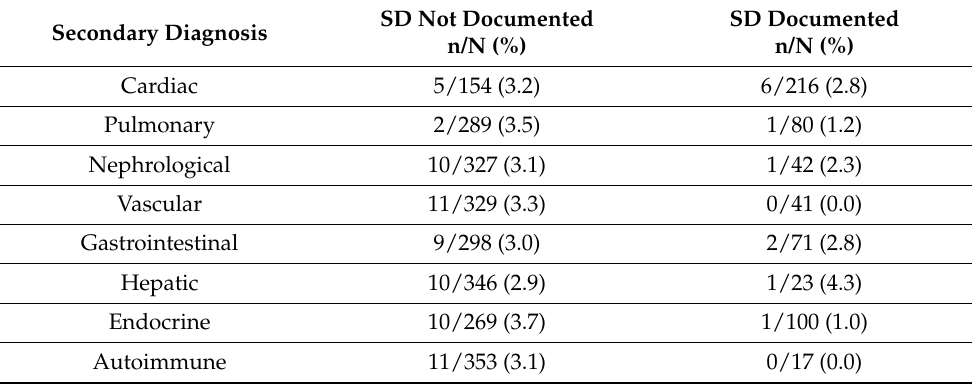
Table 2. Shingrix ® vaccination rates in oncological patients according to secondary diagnoses (SD) in frequency (n/N) and percentage